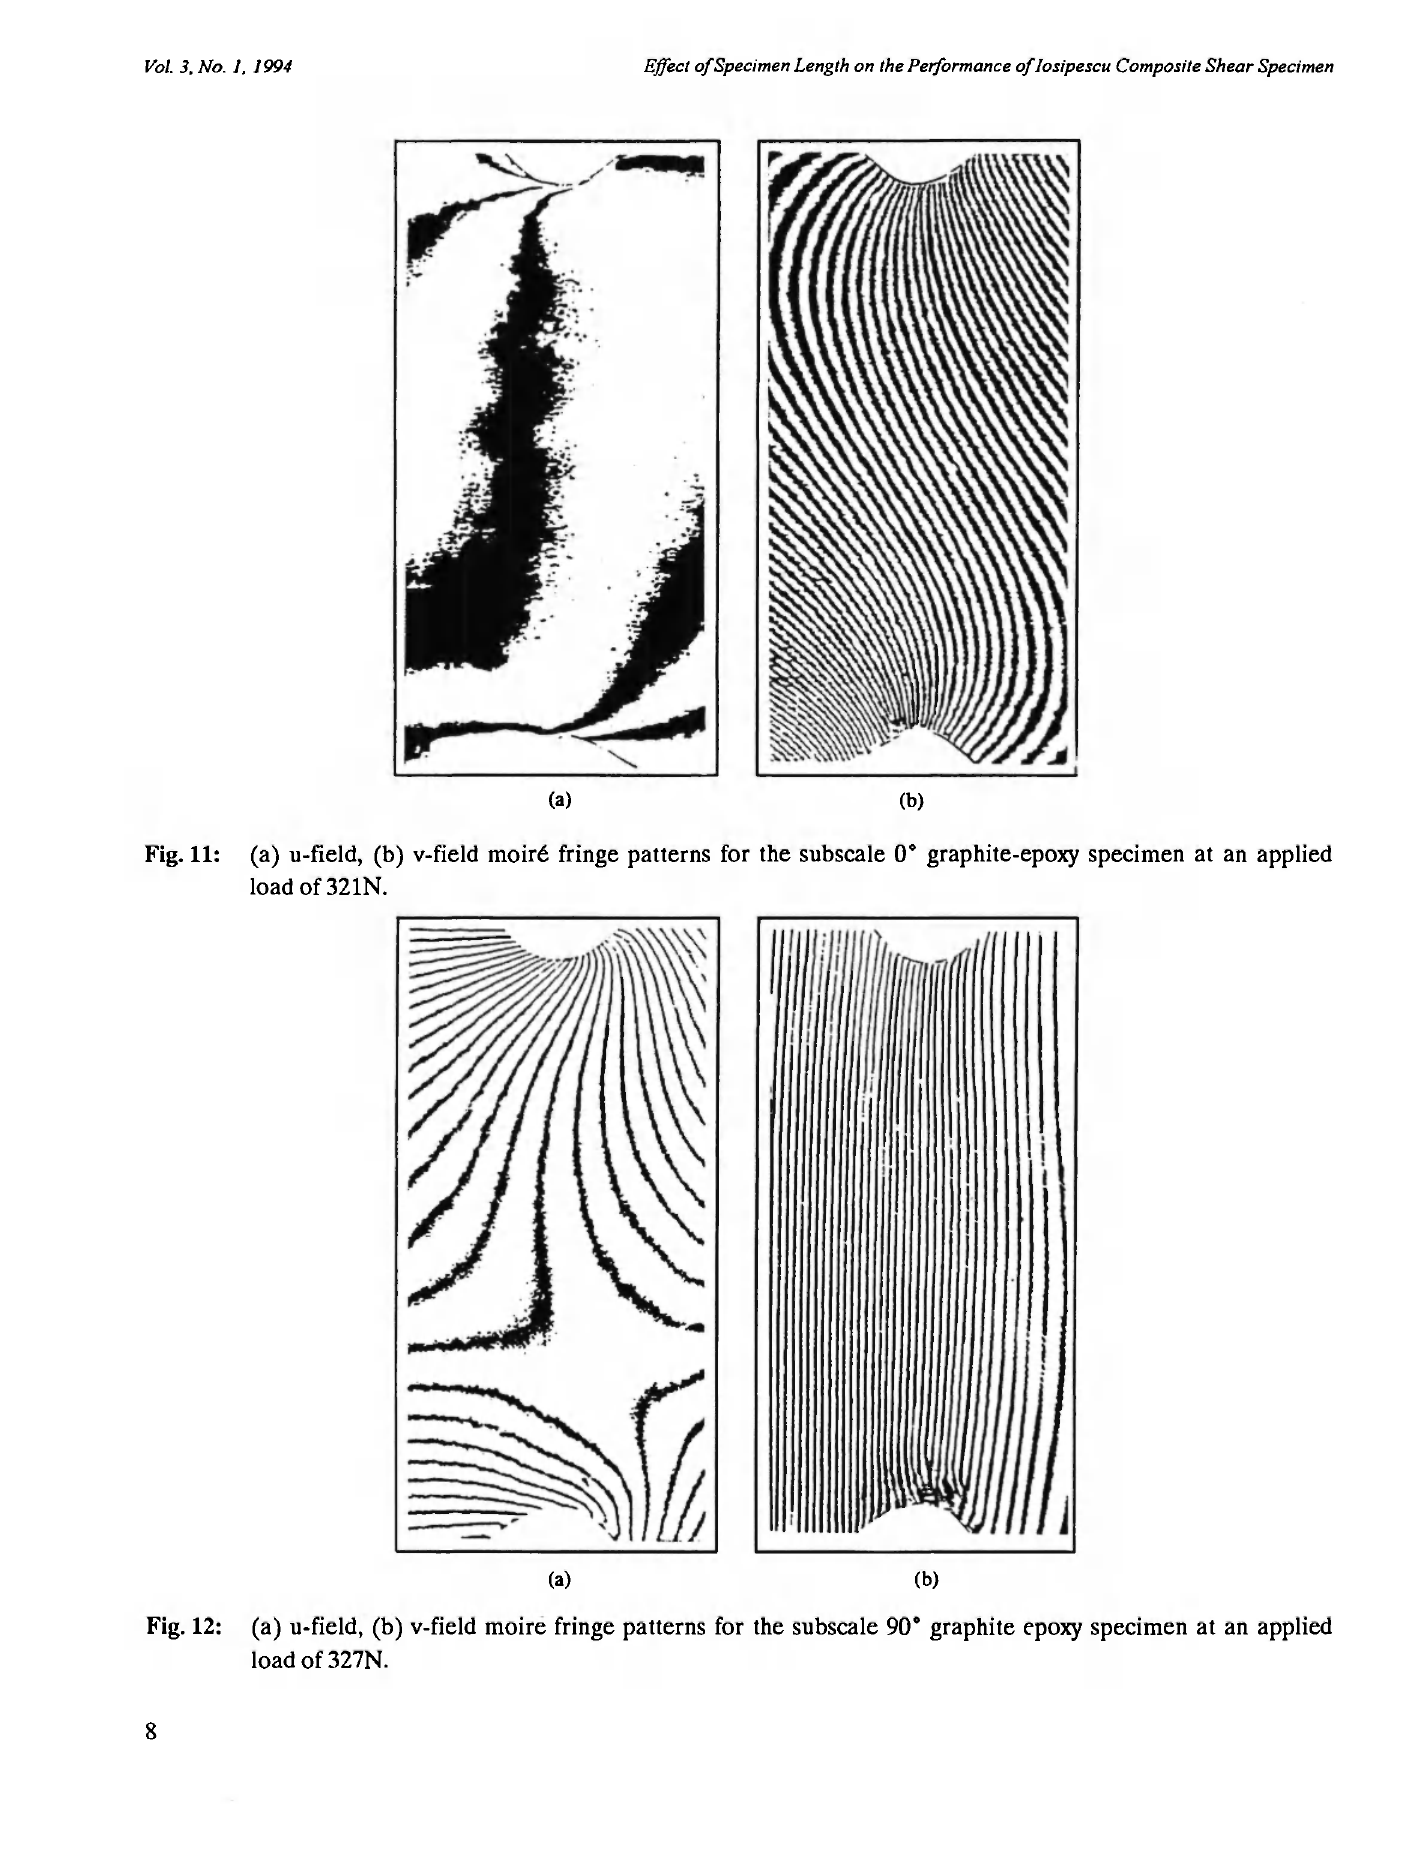
Fig. 12: (a) u-field, (b) v-field moire fringe patterns for the subscale 90° graphite epoxy specimen at an applied load of